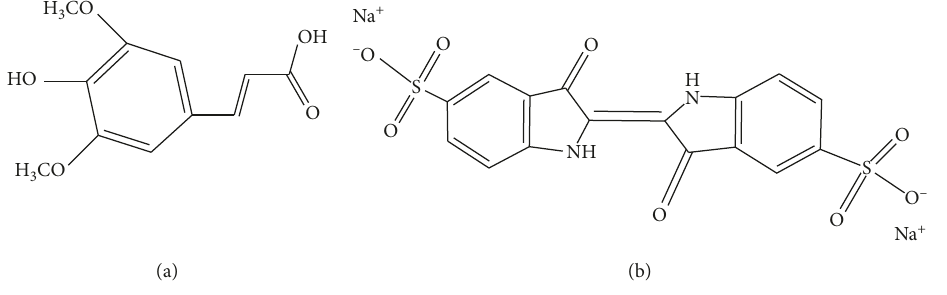
Figure 1: Molecular structures of (a) SA and (b)